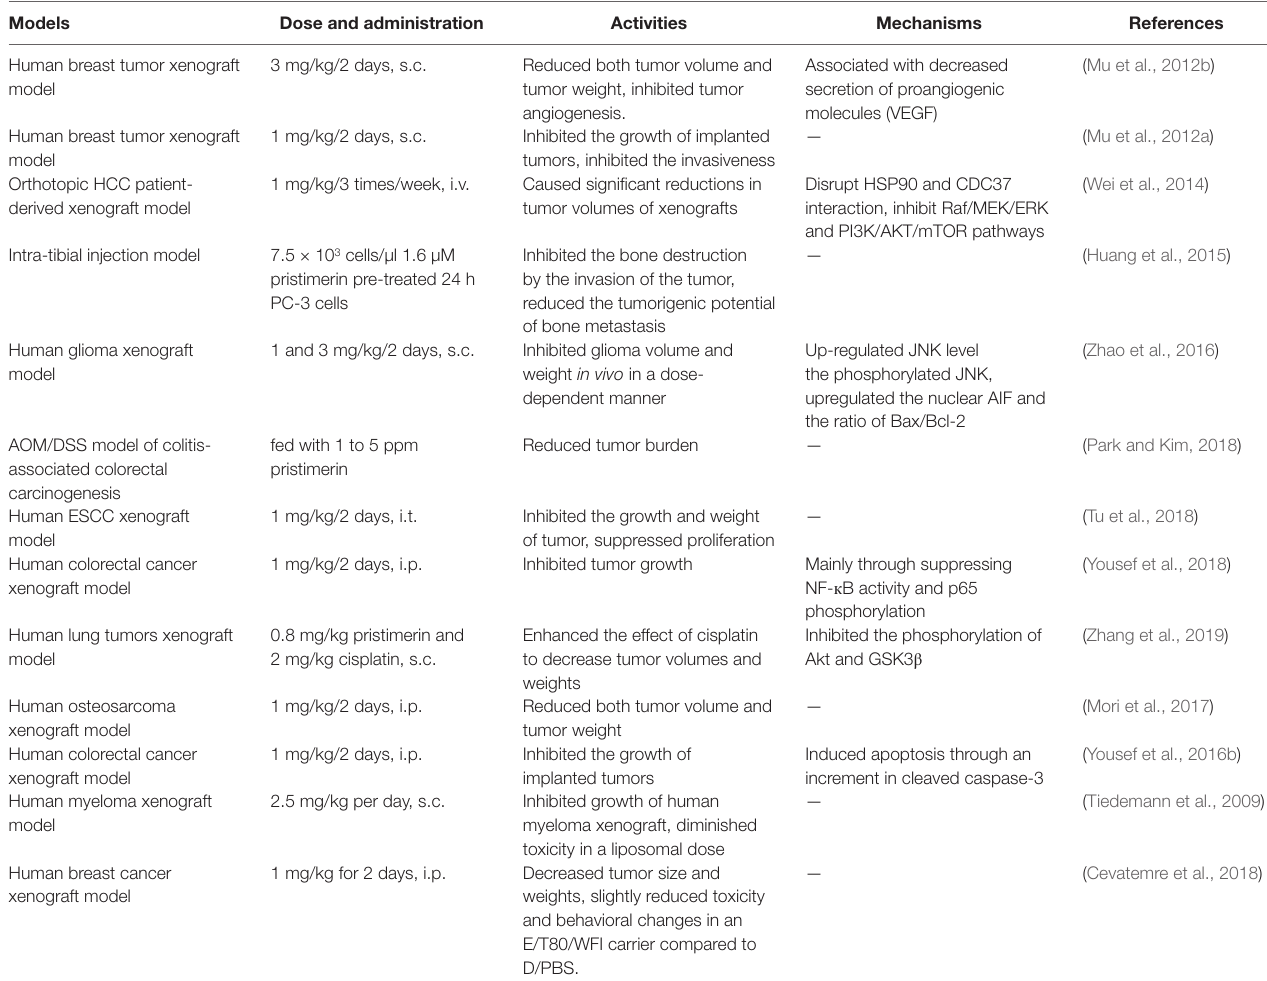
TABLE 2 | In vivo anti-tumor activities of